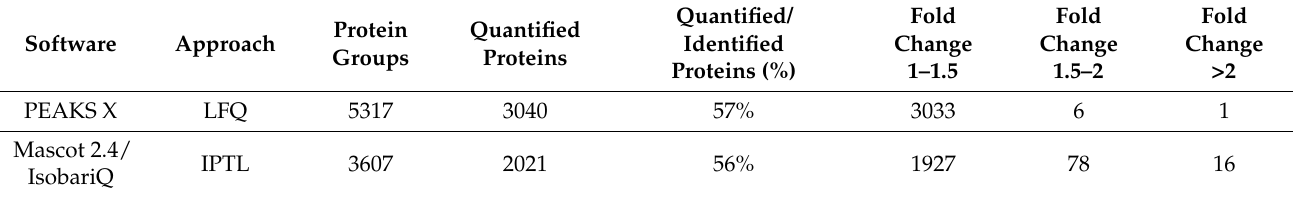
Table 2. Protein quantification for LFQ and IPTL. Eight replicates for IPTL and four against four replicates for LFQ were compared. Quantitative data analysis was performed with PEAKS X for LFQ and with Mascot and IsobariQ for IPTL. For IPTL, protein groups above the homology ion score are